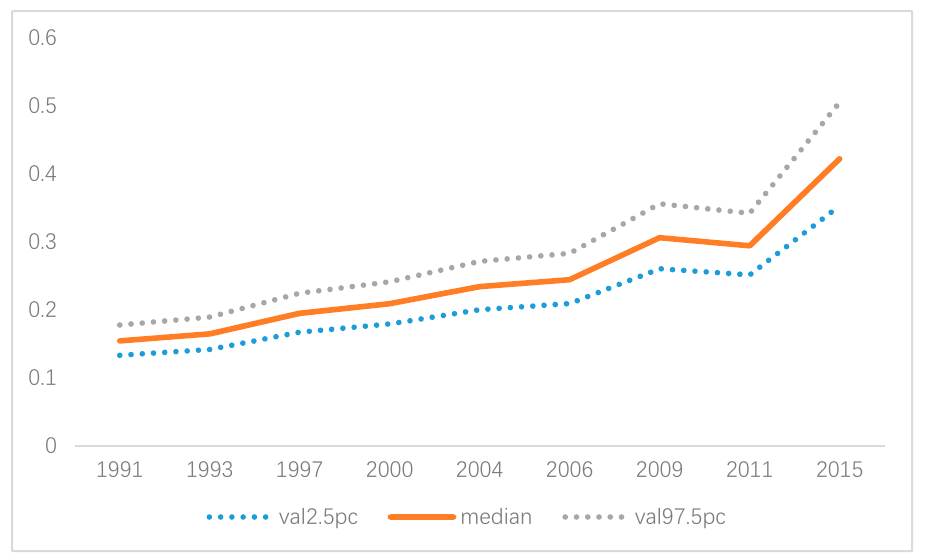
Figure 8. Weight parameter δ over time (posterior median and 95% CI).